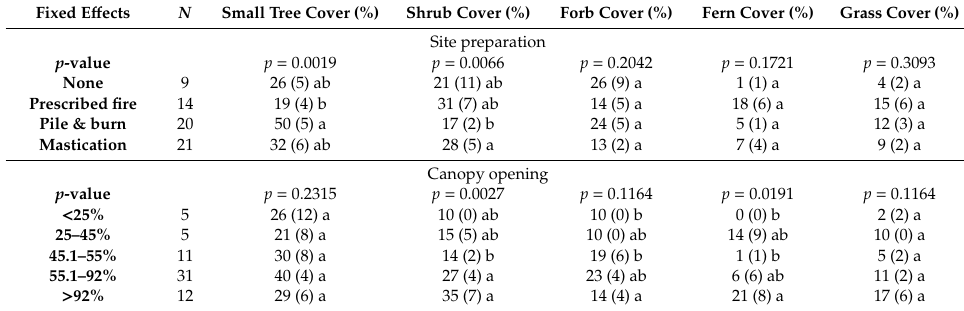
Table 3. Understory lifeforms relation to site preparation and canopy opening classes. Percent cover for small trees, shrubs, forbs, ferns, and grass across the di ff erent site preparation methods and canopy openings. Small trees and shrubs were significantly related to site preparation. Shrubs and ferns were significantly related to opening size ( p ≤ 0.05). Means with standard errors in parentheses. Letters indicate significant di ff erences among the